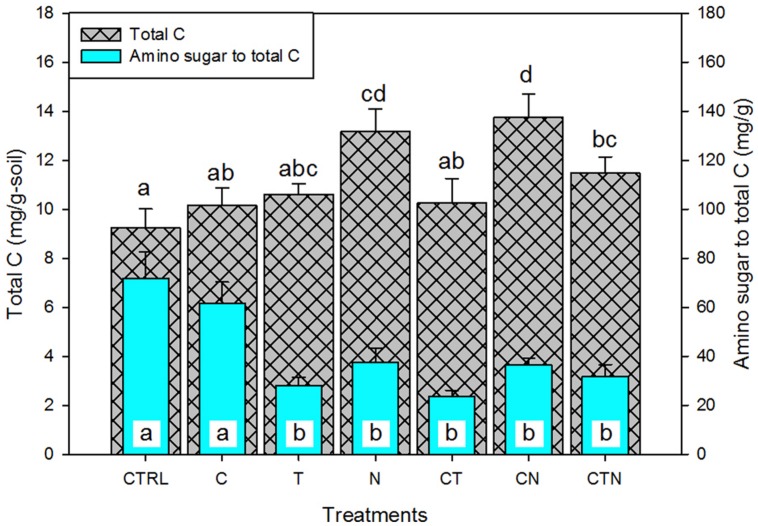
The effect of single and combined global environmental change treatments on the total carbon pool and the proportion of bulk amino sugars in that pool. CTRL, control; C, elevated CO2; T, elevated temperature; N, nitrogen deposition. Bars indicate SE of the mean (n = 4 or 5). Bars sharing a letter are not significantly different (P = 0.05, LSD test).